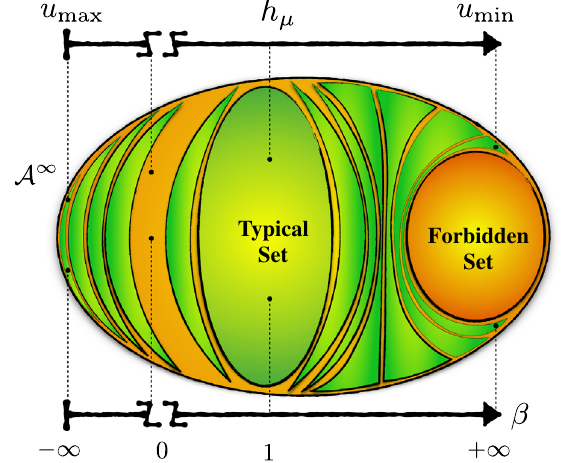
FIG. 4. Space of all sequences A ∞ partitioned into Λ P u ’ s — isoenergy density or bubbles with equal probability-decay rates — in which all sequences in the same Λ P u have the same energy density u . The typical set is one such bubble with energy equal to the Shannon entropy rate: u ¼ h μ . Another important class is the forbidden set, in which all sequences do not occur. The forbidden set can also be interpreted as the subset of sequences with infinite positive energy. By applying the map B β to the process and changing β continuously from −∞ to þ ∞ (excluding β ¼ 0 ), one can generate any rare class of interest Λ P u . β → −∞ corresponds to the most probable sequences with the largest energy density u β ¼ 1 corresponds to the typical set, and β → þ ∞ corresponds to the least probable sequences with the smallest energy density u